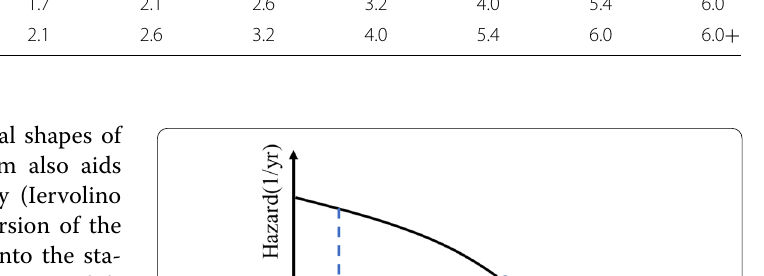
( T ) in each bin. a 1